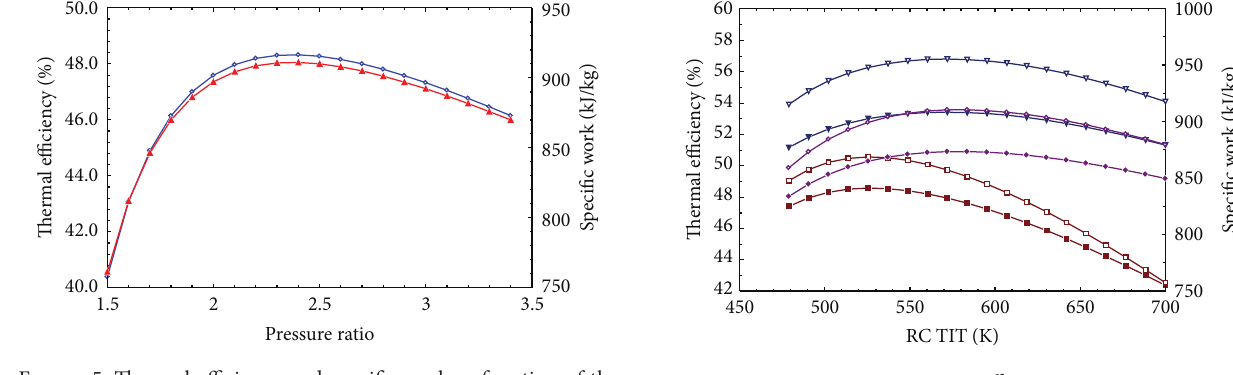
Figure 5: Thermal efficiency and specific work as function of the pressureratiofortheregenerativeCBCoperatingwithheliumasWF and TIT 1173K.